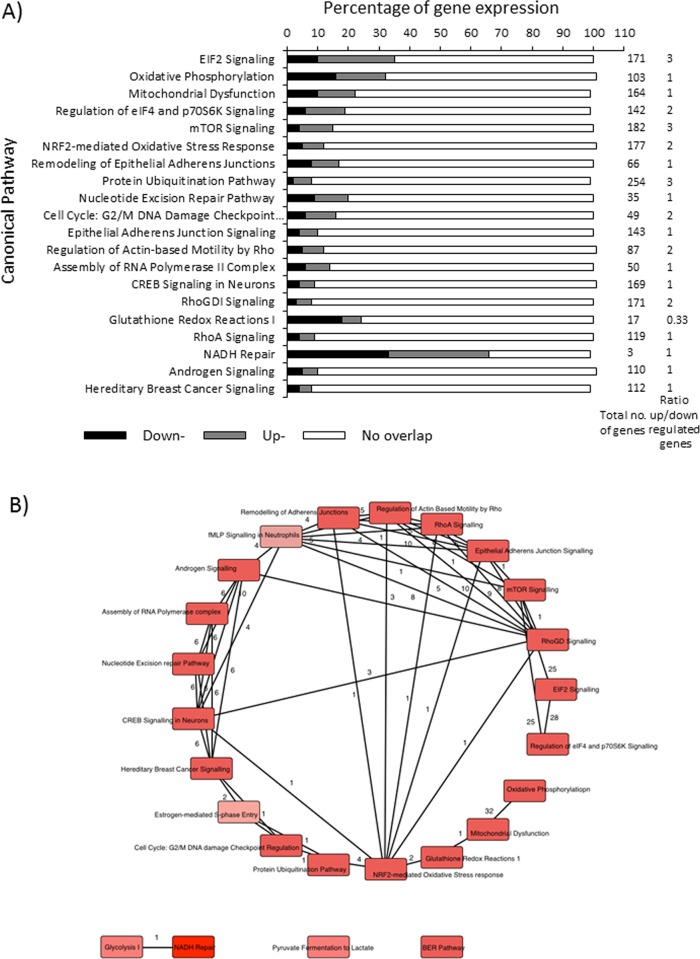
Analysis of data obtained from human microarray experiments using Ingenuity Pathways Analysis (IPA).A) IPA software v7.6 (Ingenuity® Systems, USA) was used to identify the top canonical pathways in PMC that were most affected by D39 infection. This was determined by calculating the ratio of the total number of differentially expressed genes in each pathway as a proportion of the total number of genes involved in that pathway. A minimum threshold of 5% gene perturbations was then imposed on pathways and those meeting these inclusion criteria were then ranked according to the proportion of gene perturbations. The 20 most highly ranked pathways by P-value and ratio are shown. B) Network map showing the distributions of specific genes that overlap between the top canonical pathways. The reader is referred to S3B Table for a complete listing of canonical pathways.